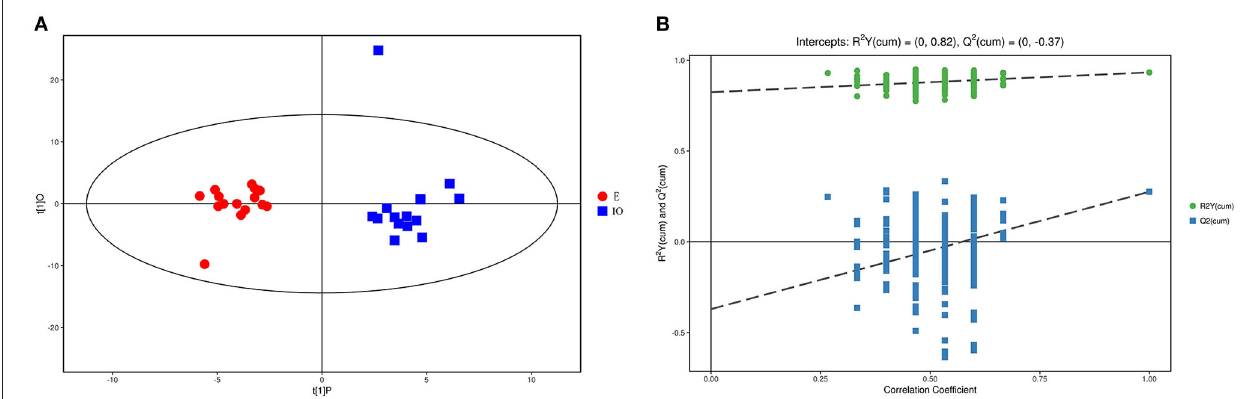
FIGURE 1 | Score scatterplot of the OPLS-DA model and the permutation test for the estrus E (red) vs. inactive ovaries IO (blue) group. (A) A scatterplot whereby the abscissa represents the predicted score of the first principal component; the ordinate represents the orthogonal principal component score, and the scatter colors represent different experiment groups. (B) Result of the displacement test whereby the abscissa indicates the displacement retention; the ordinate indicates the value of R 2 Y or Q 2 , the green dot indicates the R 2 Y value, the blue square indicates the Q 2 value, and the dotted line indicates the regression line.